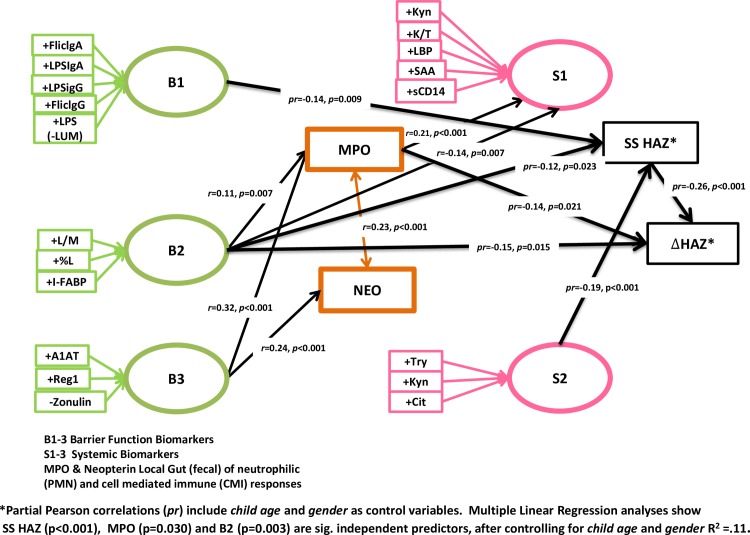
Path model, using Principle Components Analyses (Equamax rotation solution maximizing independence of groups) showing associations among 1) Barrier (green), 2) Local Gut (orange) and 3) Systemic (pink) sets of biomarkers, as well as their predictive utility regarding linear growth.